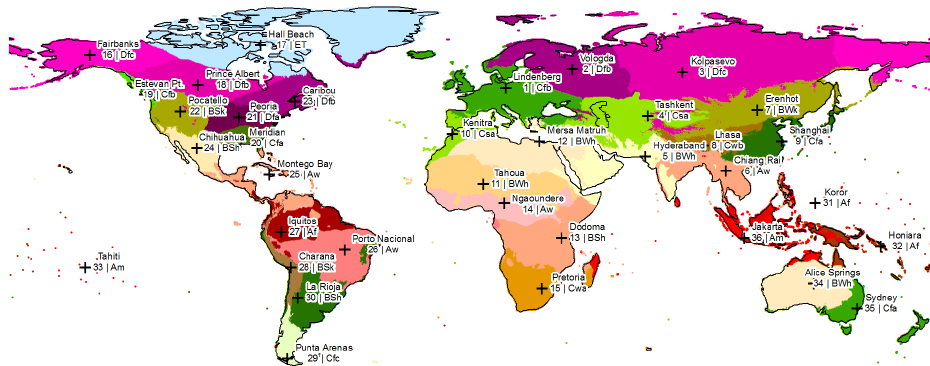
Fig. 3. Map of 36 climatic zone domains used in RCWIP, derived by fuzzy clustering but here shown with defined boundaries. The “+” symbol denotes the spatial location of each climatic zone centroid. The descriptions of each of these climatic zones are denoted by a number (zone no.) and a Köppen–Geiger climatic zone description (e.g., Dfc). These are fully tabulated in Table 2 and Sheet S2 in the